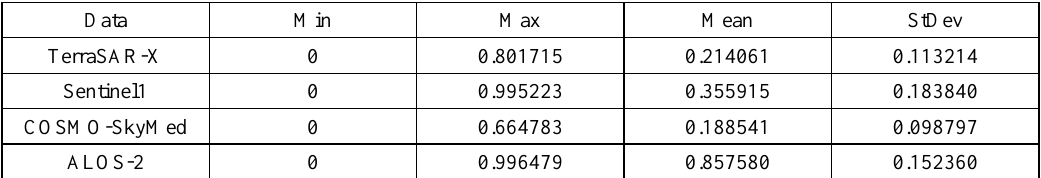
Table 2 The statistical results of the four groups of interference